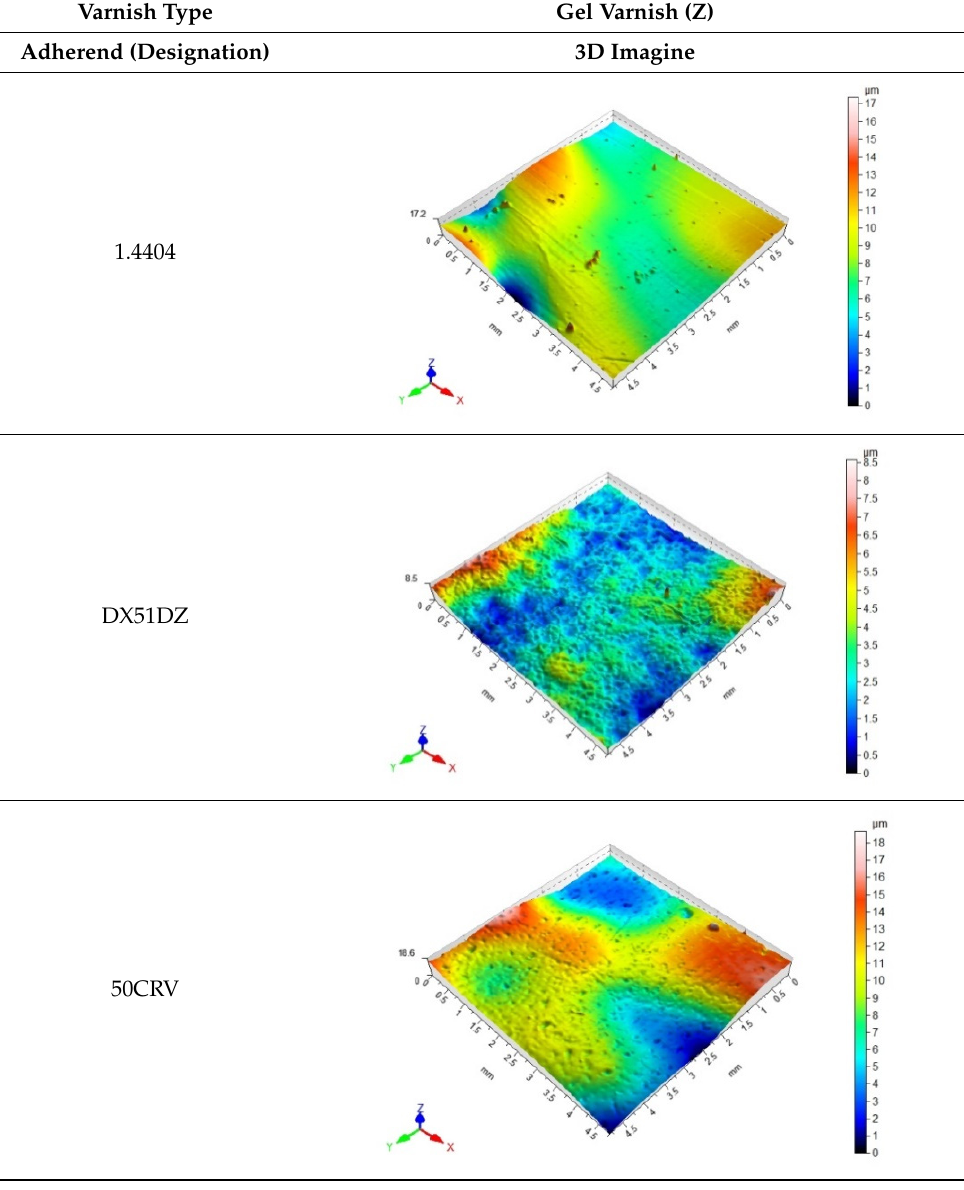
Table 14. Average values of 3D height parameters.